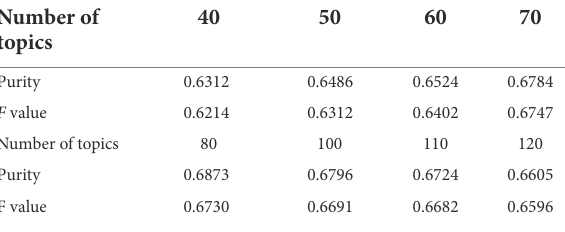
TABLE 4 Cluster purity and F value expressed by emotional features.